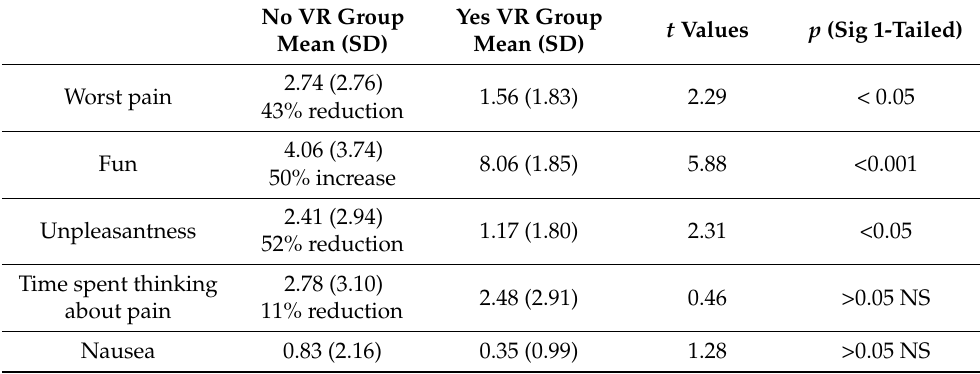
Table 2. (Ages 7–17). Pain, fun, and nausea mean levels in the experimental and control